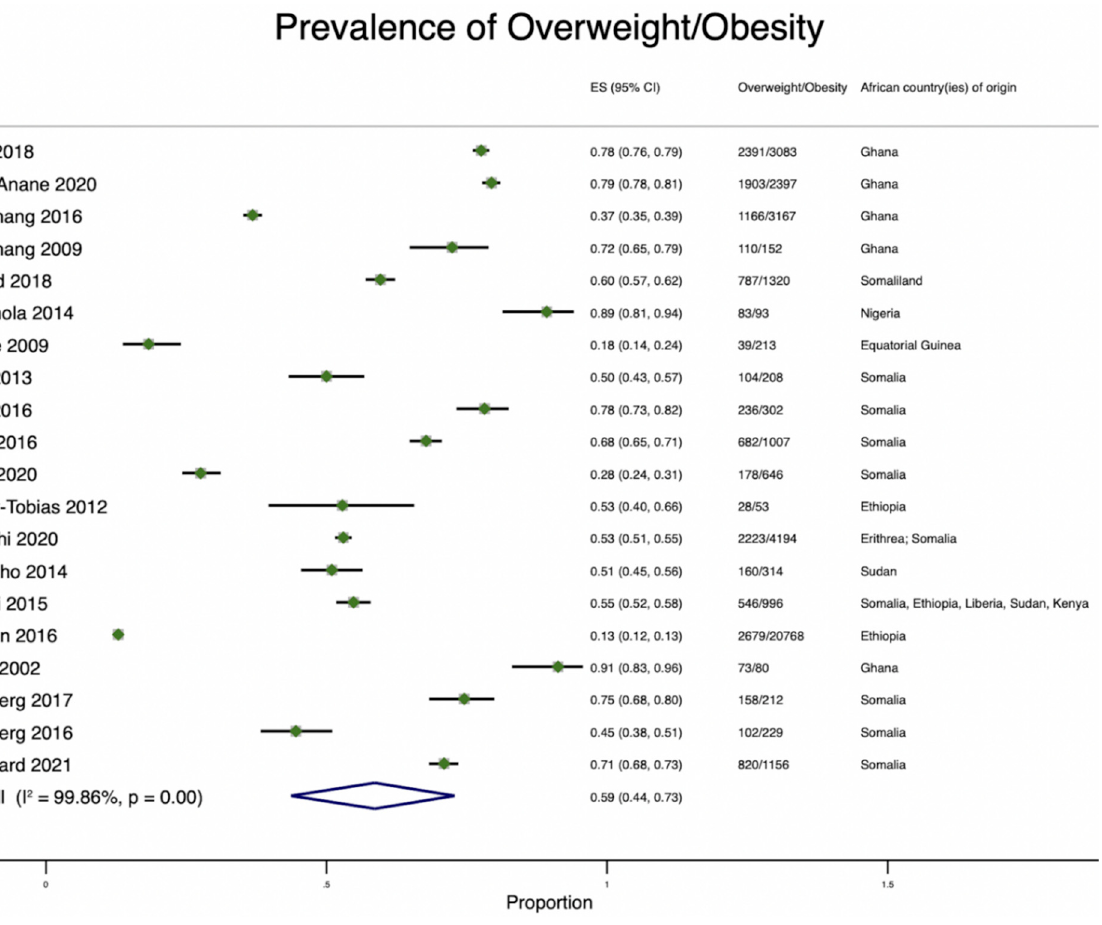
Figure 5. Pooled Prevalence of overweight/obesity among African immigrants residing in high-income countries.